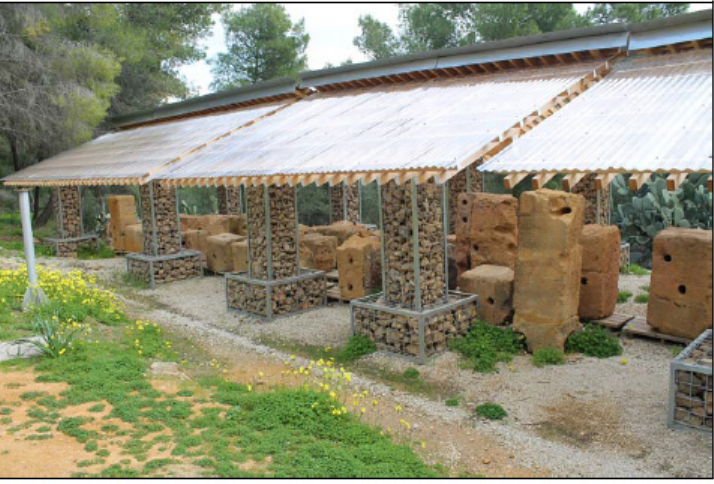
Figure 11. South orientation of one of the location designed to host the PV system.